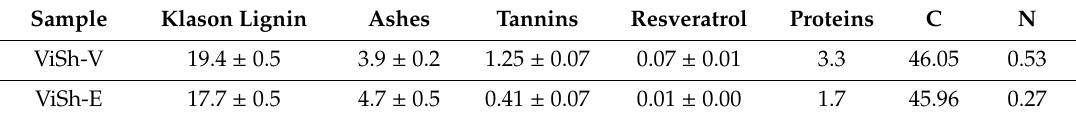
Table 1. Biochemical composition (% dry basis) of vine shoots (ViSh) fillers.